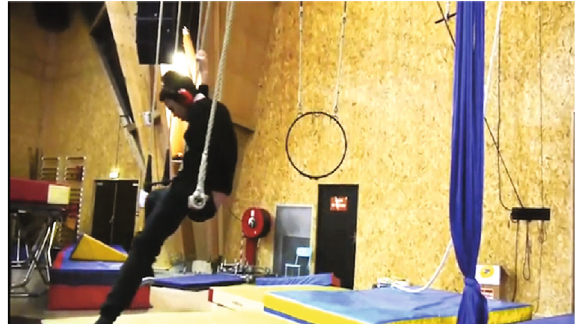
Figure 8: Participant swinging on the trapeze